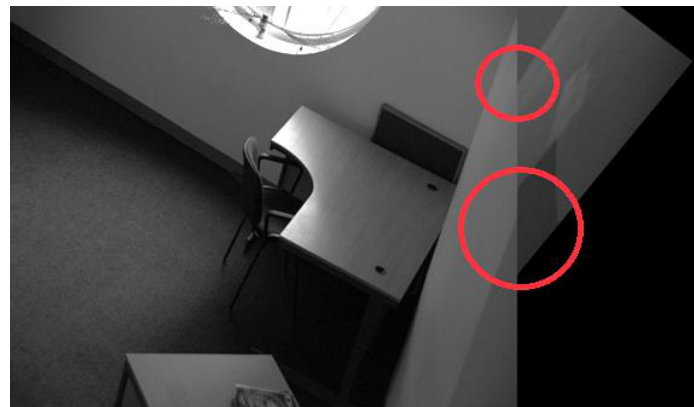
Figure 15. Image registration result for the image pair 8 of the database using IBR alone. The regions inside the red circles indicate poor image